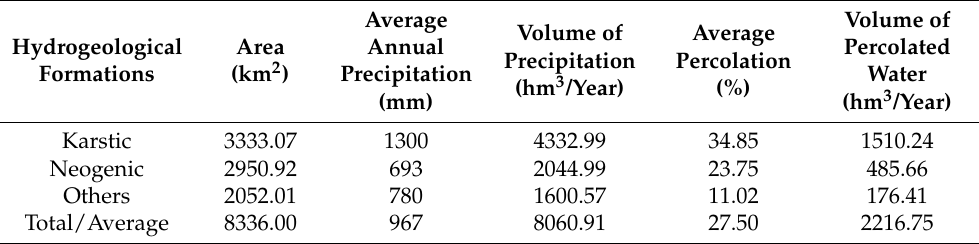
Table 8. Water potential of major hydrogeological units of Crete (table data are based on estimates of over 91 individual hydrogeological units throughout Crete). Source: